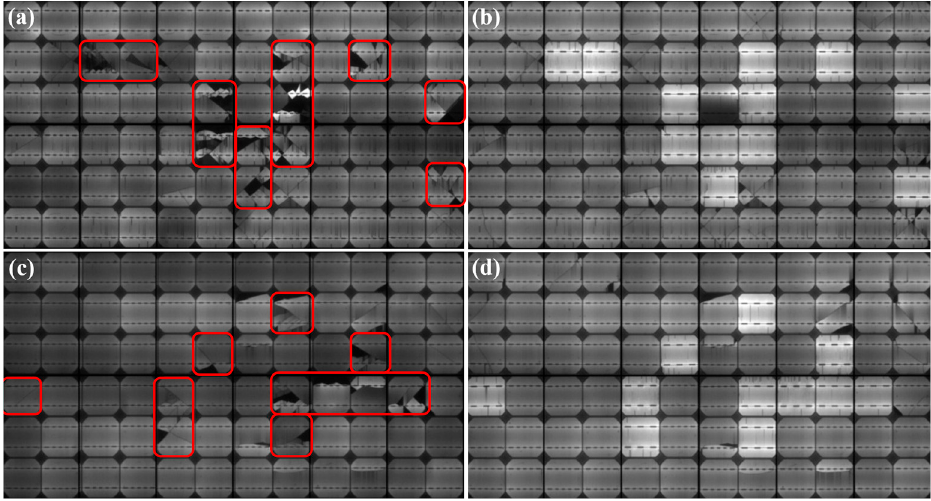
Figure 1. EL image before and after repair of 175 Wp single crystal solar modules. Table 2. Electrical characteristics of 175A and 175B samples at each